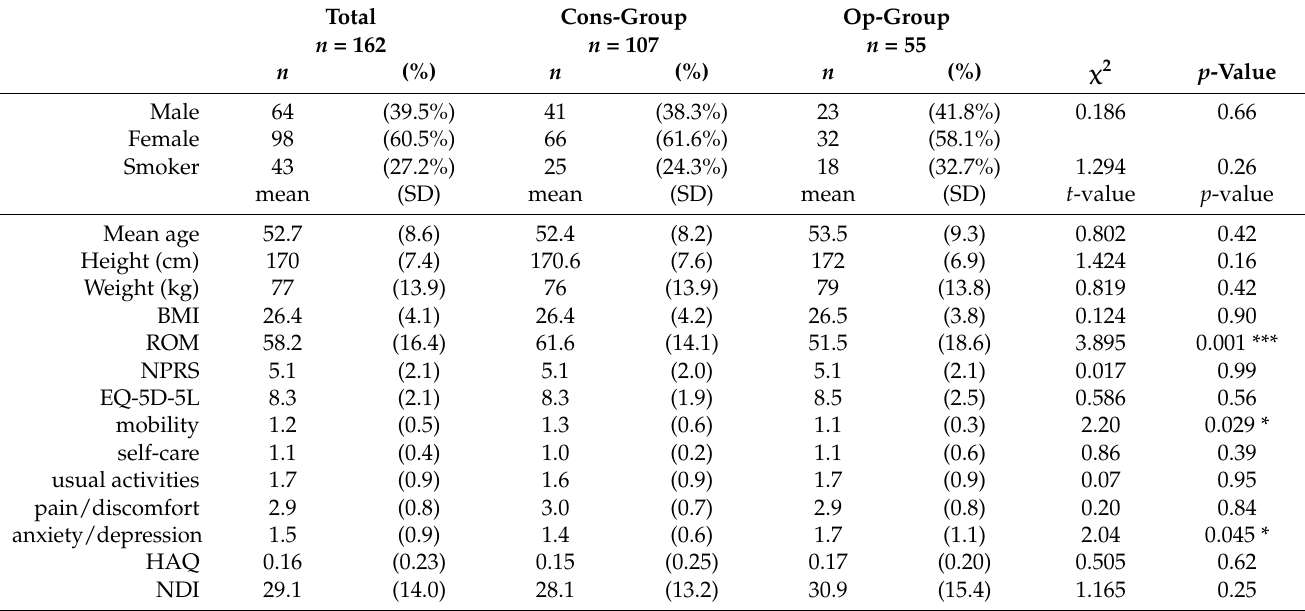
Table 1. Sociodemographic data and baseline PRO